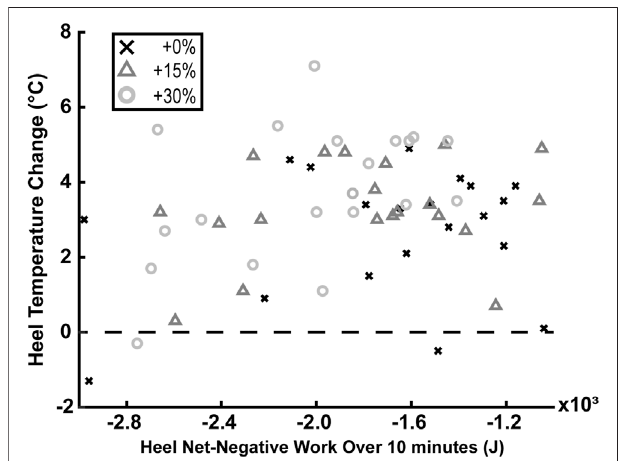
FIGURE4 | There wasno statistically signi fi cantcorrelationbetween the heel ’ s net-negative mechanical work extrapolated to 10 min of barefoot walking and the heel ’ s temperature change after 10 min of barefoot walking ( p = 0.277; N = 20). Values above the dashed line indicate that the temperature increased, while values below indicate the temperature